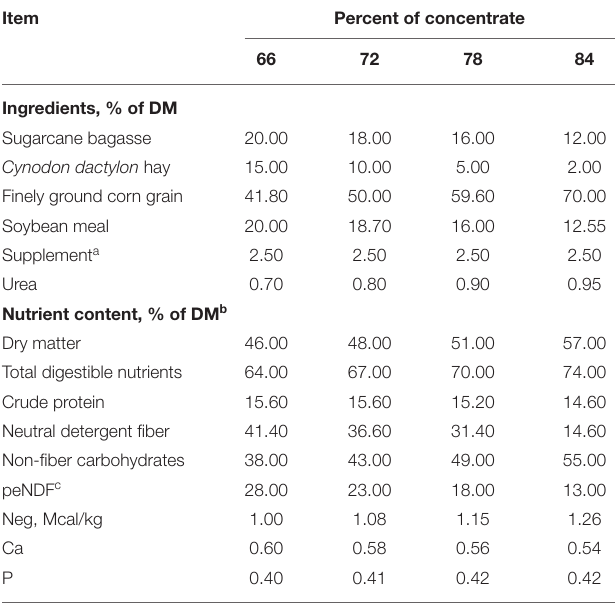
TABLE 1 | Feed ingredients and chemical composition of high-concentrate diets fed to Nellore yearling bulls during adaptation and finishing